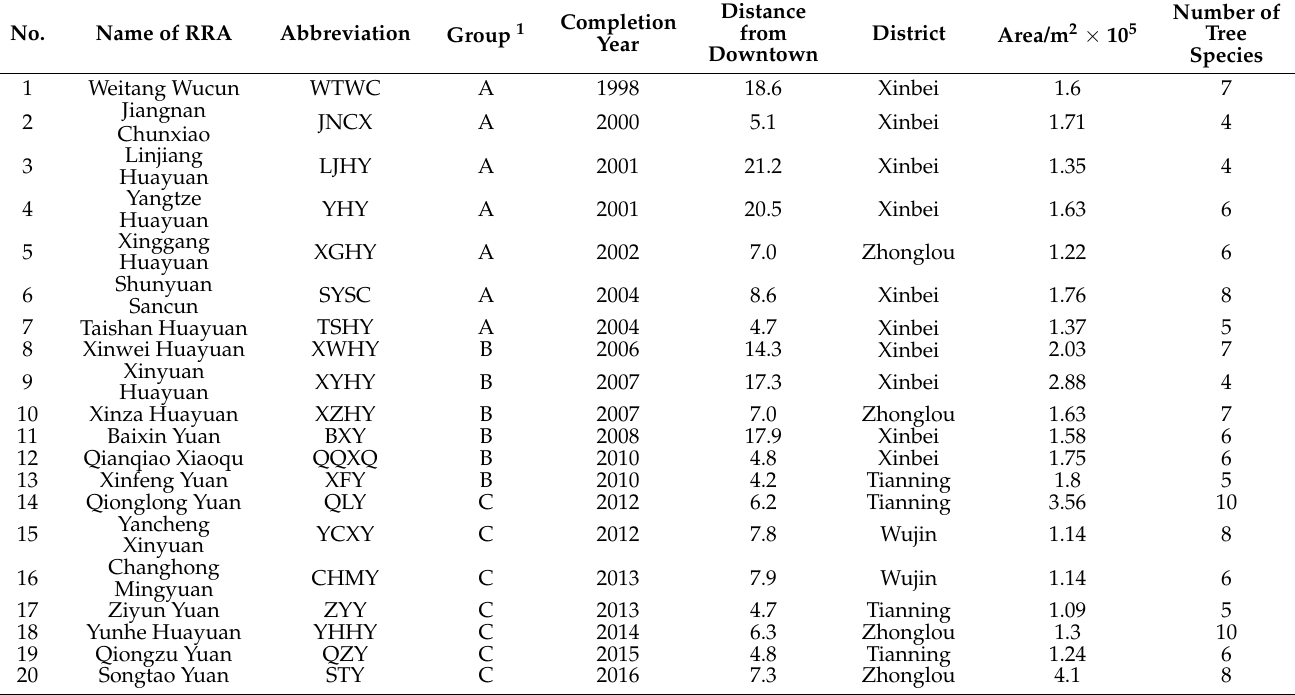
Table 1. Basic information of the 20 sampled resettlement residential areas (RRAs) of Changzhou arranged in chronological order of completion